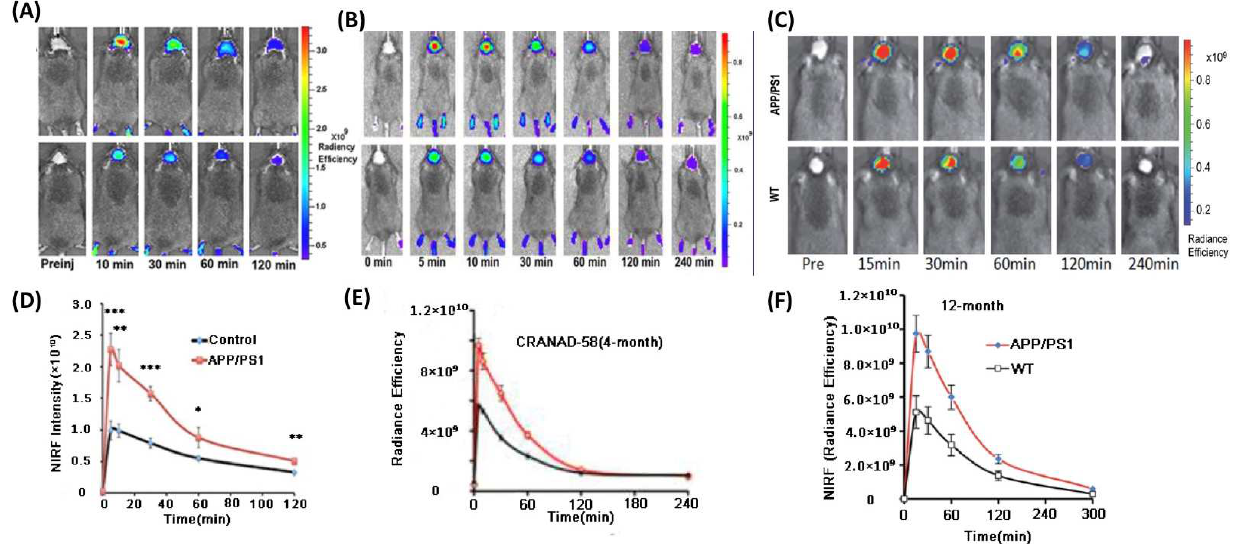
Figure 4. ( A – C ) Representative images of APP/PS1 transgenic and wild-type mice at different time points of CRANAD−3, 58 and 102, reprinted with permission from [52] . Copyright 2013 American Chemical Society. ( D – F ) Quantitative analysis of fluorescence signals between APP/PS1 and WT mice. * p < 0.05, ** p < 0.01, *** p < 0.005. Reprinted with permission from [54] . Copyright 2019 Royal Society of Chemistry.